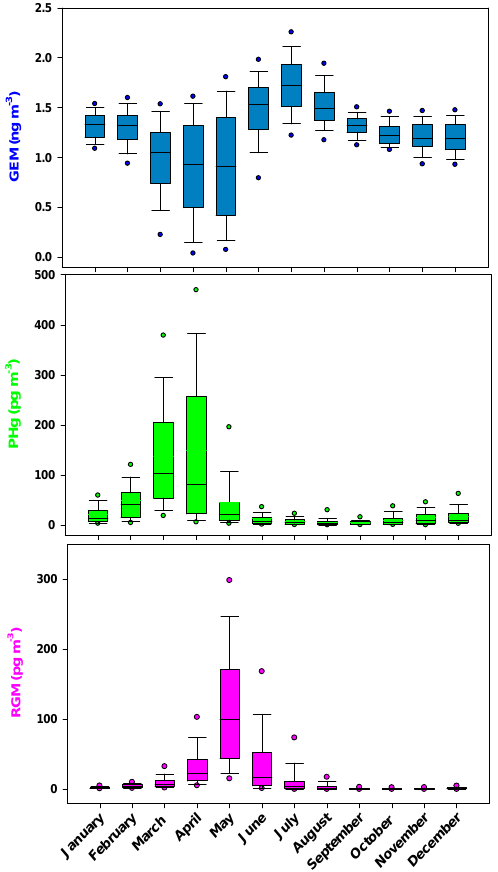
Fig. 2. Box and whisker plots of monthly gaseous elemental mer- cury (GEM-blue), particulate mercury (PHg-green) and reactive gaseous mercury (RGM-pink) from Alert, 2002–2011. GEM is in ngm − 3 and PHg and RGM are in pgm − 3 . Centre line in the box represents the median value, the boundaries of the box represent the 25th and 75th percentiles, the whiskers represent the 10th and 90th percentile and the dots represent the 5th and 95th percentile.